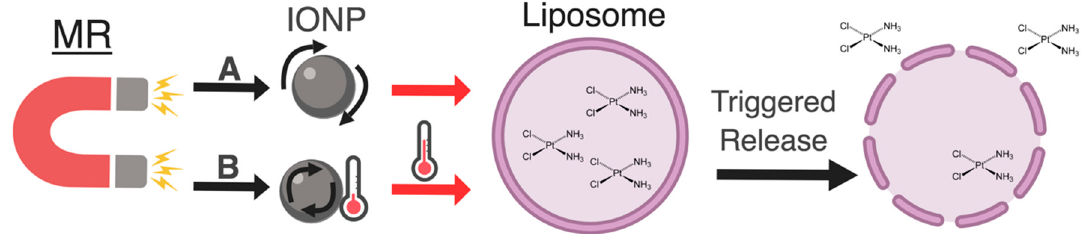
Figure 3. Schematic of the mechanisms associated with MR that can be used to destabilize liposomes. The mechanisms are: ( A ) MR induced mechanical disruption; ( B ) MR induced